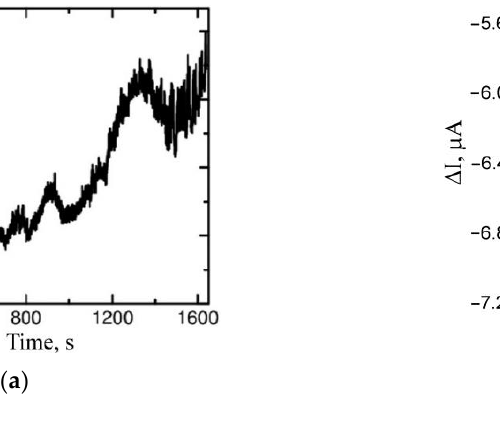
Figure 7. Examplary courses of potential vs. time ( a ) and current noise vs. time ( b ) of remelted AZ91 alloy after 5 h immersion in 0.5 mol/dm 3 NaCl solution saturated with Mg(OH) 2 .